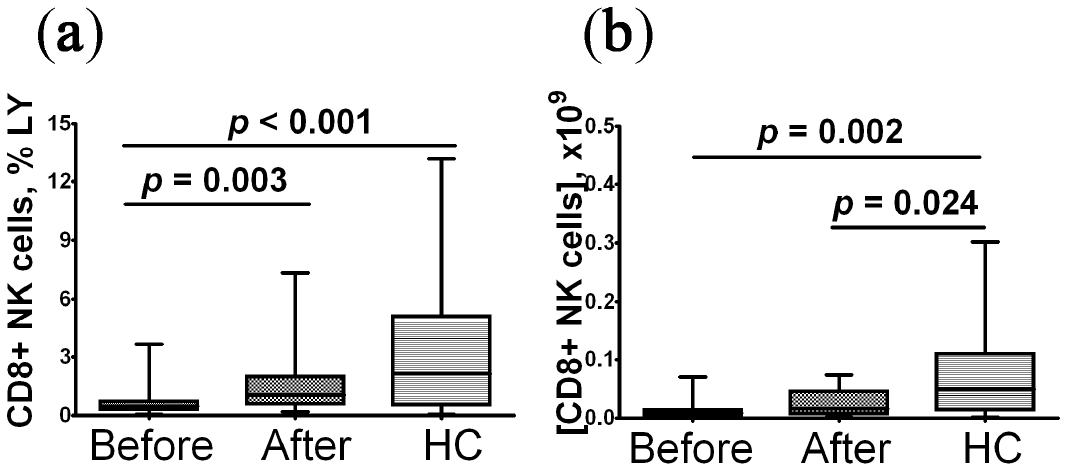
Figure 1. Alteration in relative and absolute level of peripheral blood NK cells in convalescent COVID-19 individuals before ( n = 29) and after ( n = 29) rhIL-2 treatment vs. the healthy control group (HC, n = 30). ( a , b ) – NK cells frequencies (% from total lymphocytes subset) and absolute numbers (number of cells in 1 litter), respectively. A comparison with the indicators of the control group was performed using the Mann–Whitney U test. A comparison of parameters in the patients before and after treatment with rhIL-2 was performed using the Wilcoxon matched pairs